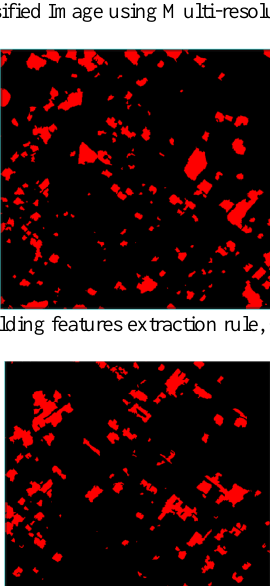
Figure 8 Building features extraction rule, Spectral Mean